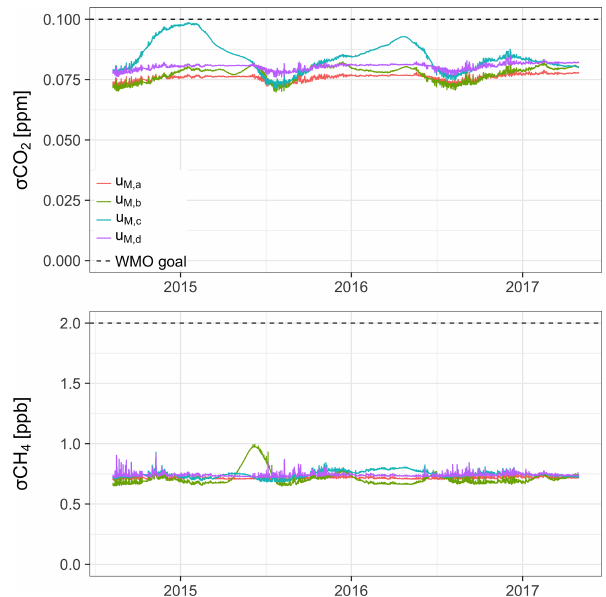
Figure E1. Estimates of CO 2 and CH 4 measurement uncertainty as defined in Eqs. (E3)–(E6). The dashed lines are the WMO interlab- oratory compatibility